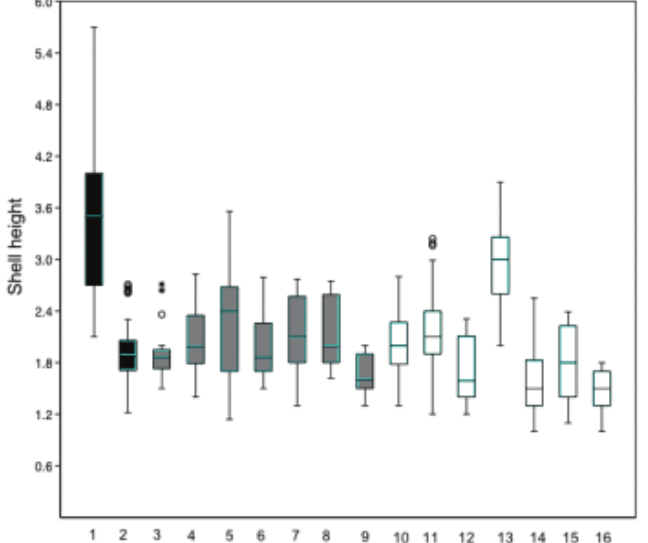
Figure 9. Boxplots showing shell heights on Potamolithus spp. Horizontal Bar, median; vertical bar, whiskers with minimal and maximum observations. 1 P. ribeirensis 2 Potamolithus sp. 1 3 P. karsticus 4 Potamolithus sp. 2 5 Potamolithus sp. 3 6 Potamolithus sp. 4 7 Potamolithus sp. 5 8 Potamolithus sp. 6 9 Potamolithus sp. 7 10 P. troglobius 11 Potamolithus aff. t roglobius 12 Potamolithus sp. 8 13 Potamolithus sp. 9 14 Potamolithus sp. 10 15 Potamolithus sp. 11 16 Potamolithus sp. 12. Black bars, epigean species; gray bars, troglophilic species; white bars, troglobitic species; circles, outliers; *, extremes.